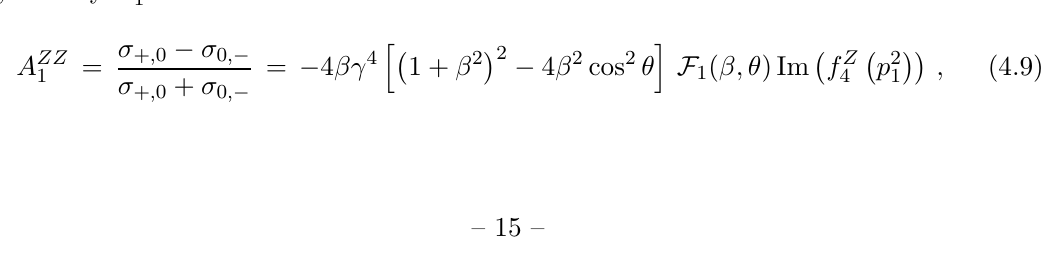
for the ZW + W (cid:0) vertex from eq. (4.8), as a 4 = (450 GeV) 2 . In red, points for which the masses of all 1 < 200 GeV ( i = 1 ; 2 ; i